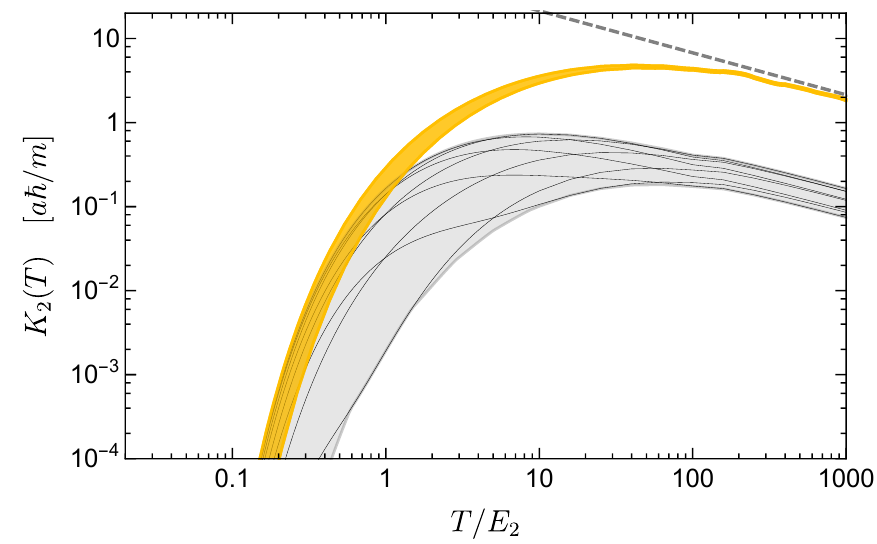
Figure 4 . Rate coe(cid:14)cient K 2 ( T ) for dimer breakup as a function of the temperature T . The upper band is the envelope of K 2 ( T ) for all possible values of the three-body parameter a + . The dashed line is the extrapolation from the scaling behavior in eq. (4.7). The lower band is the envelope of the J = 0 contribution to K 2 ( T ) for all possible values of a + . The curves inside the lower band are for 8 values of a + : a + =a = (cid:21) n= 8 , n = 0 ; 1 ; : : : ; 0